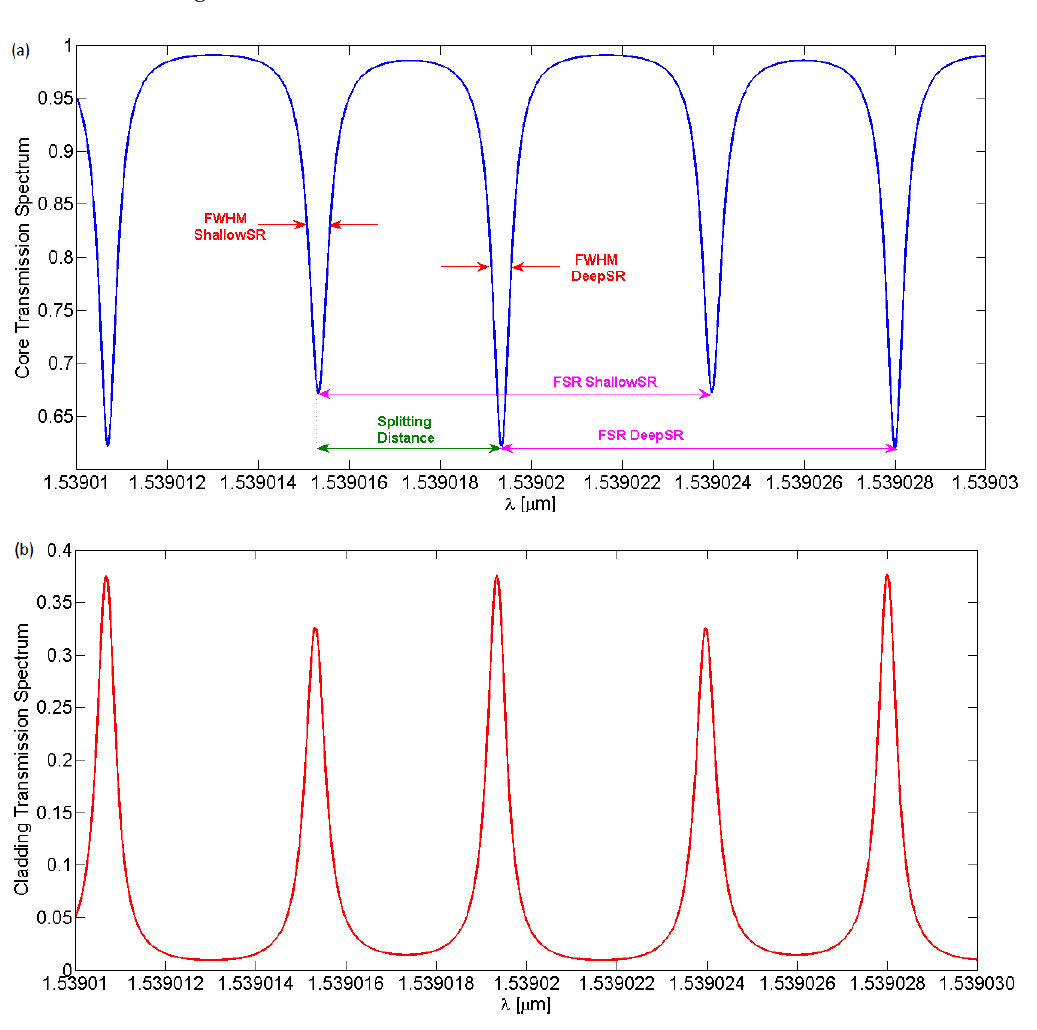
Figure 5. ( a ) LPGRR core spectrum with figures of merit labeled in; ( b ) LPGRR cladding spectrum.